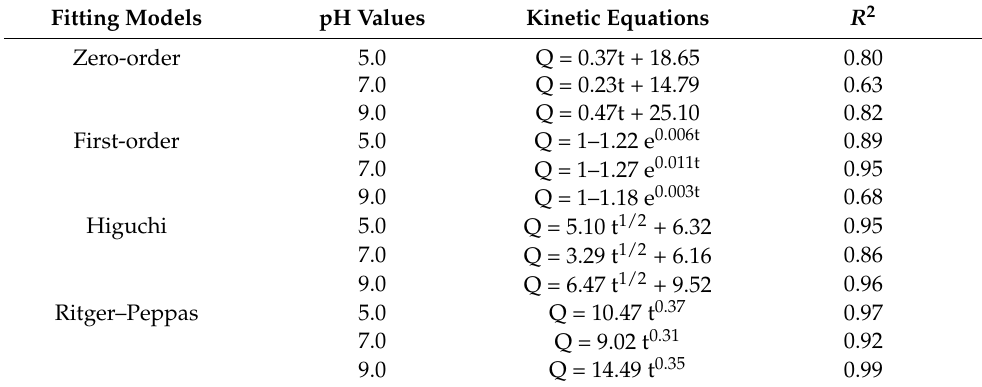
Table 2. Release kinetics parameters of Pro@BMMs − PMAA/Fe 3+ Nps at different pH values.